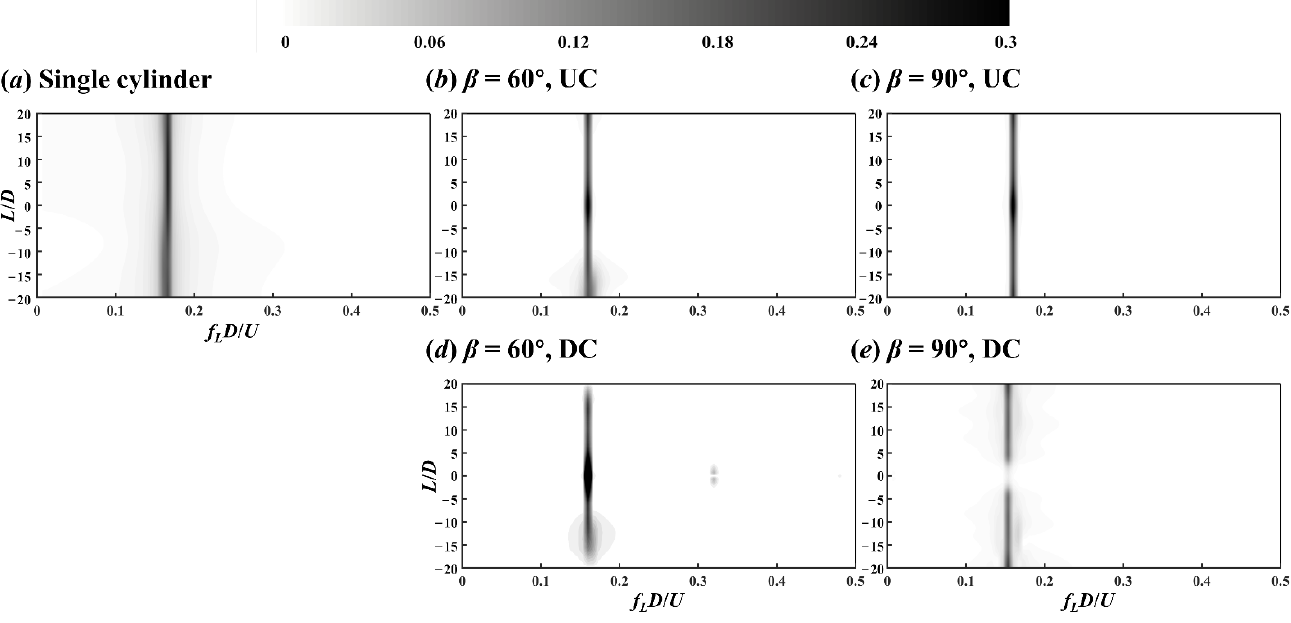
Figure 5. Contours of PSD calculated by sectional lift coefficient along the single cylinder ( a ), and UC ( b , c ) and DC ( d , e ) in 60° (middle) and 90° (right) arrangements.